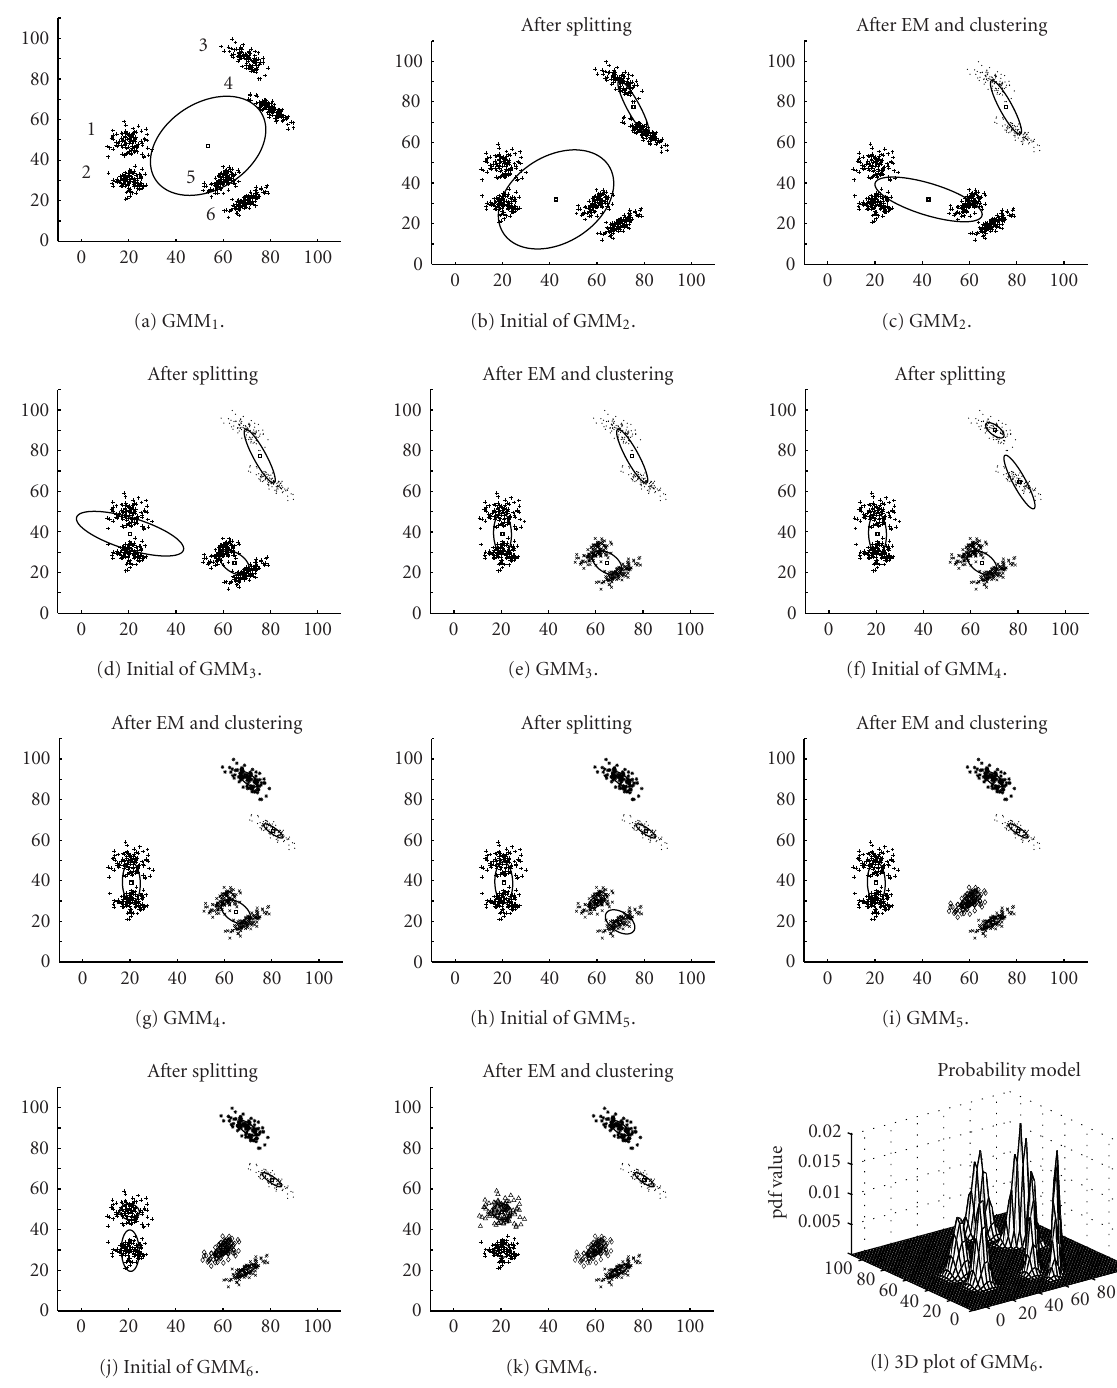
Figure 1: The learning process of applying the SGML in the synthetic data, in which full covariance GMMs were used. When we used the diagonal covariance GMMs for the same task, as shown in Figure 3, the SGML grouped the syn- thetic data into ten clusters. From the perspective of “Gaus- sian mixture modelling” instead of the perspective of “data clustering,” the learning process could be divided into three